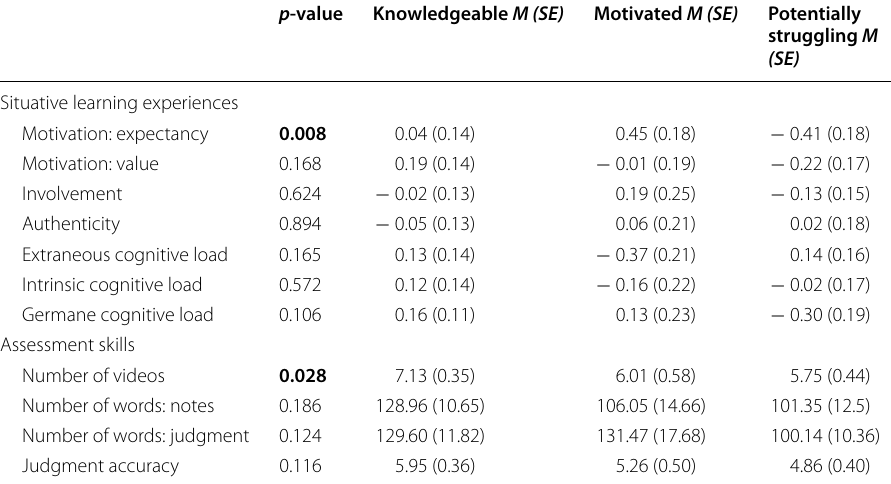
Significant differences between profiles are highlighted in bold